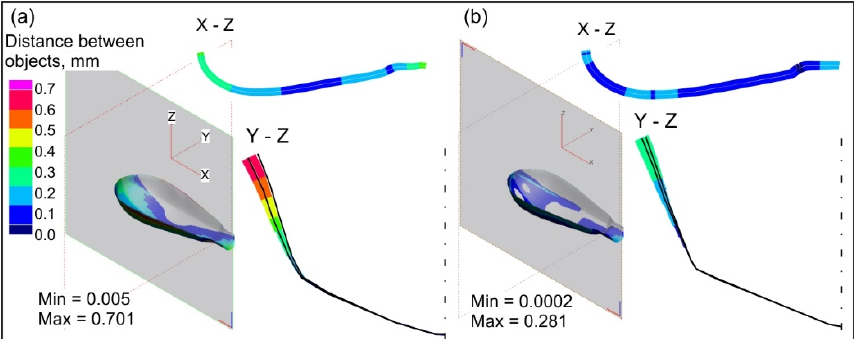
Figure 14. Springback after flange trimming: ( a ) initial forming without blank holder, ( b ) initial forming with blank holder and lubrication.